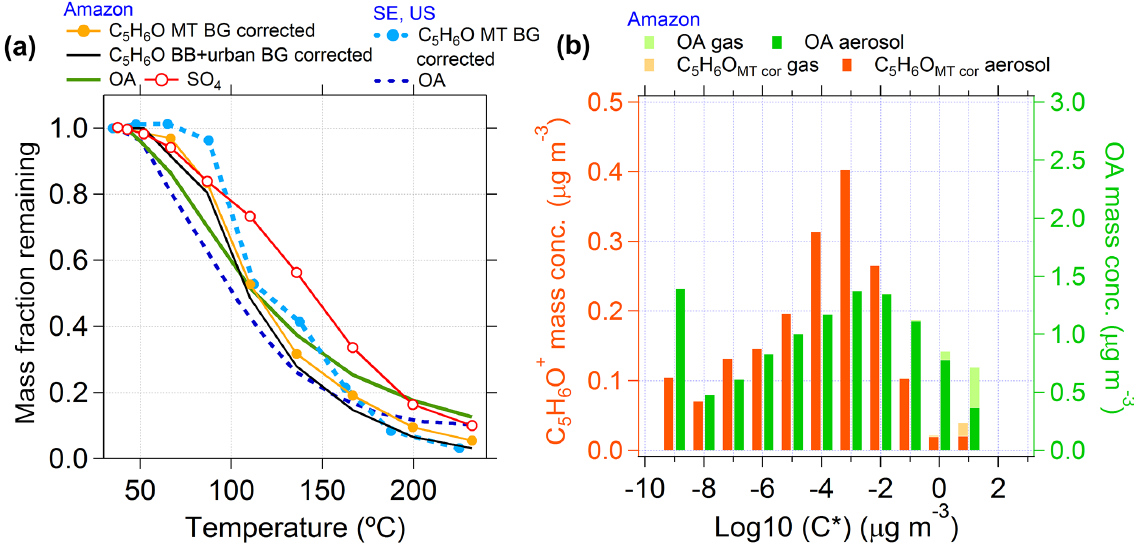
Figure 2. (a) Thermogram of OA, SO 4 , and background-corrected C 5 H 6 O + ion in the SE US and Amazon studies. (b) Volatility distributions of C 5 H 6 O + and OA estimated based on TD thermograms from the Amazon study.